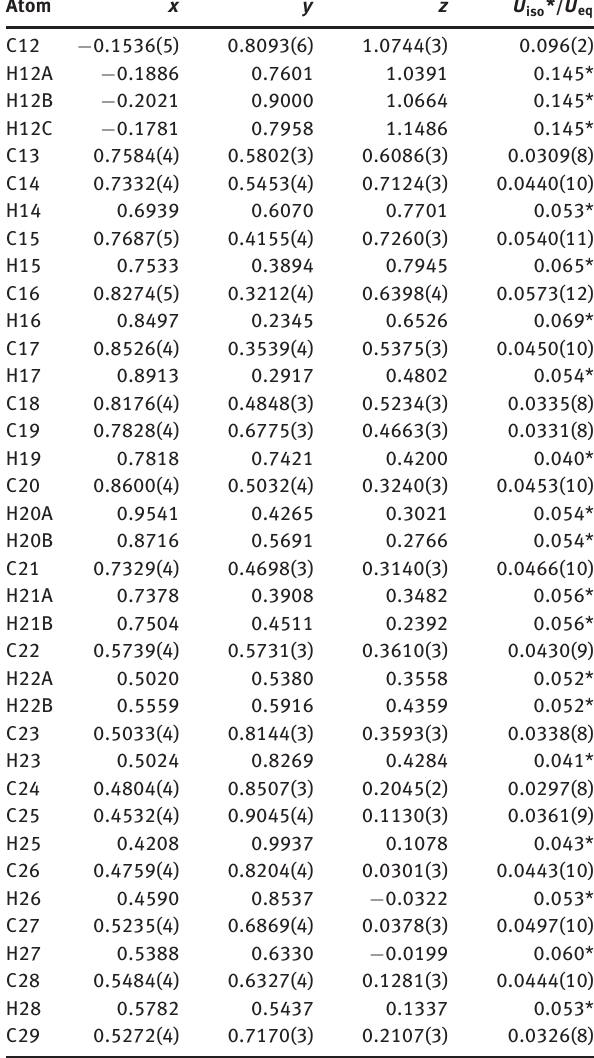
figure. Tables 1 and 2 contain details on crystal structure and measurement conditions and a list of the atoms including atomic coordinates and displacement parameters. Source of